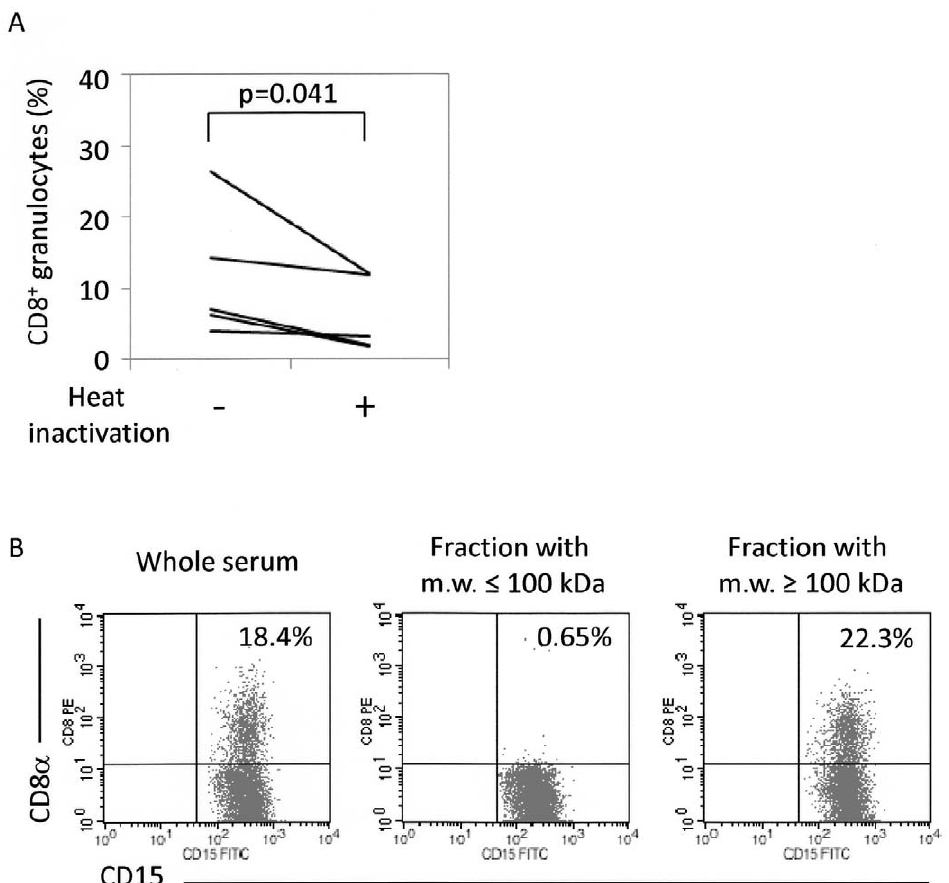
Figure 5. Characterization of serum factors that contribute to Fc c R-mediated trogocytosis. ( A ) Heat instability of serum factors that contribute to Fc c R-mediated trogocytosis (n=5). PMNs and PBMCs were mixed in sera, which had been heated at 56 u C for 30 min, or sera without heat inactivation. These cells were then made to react with the PE-labeled anti-CD8 a Ab (HIT8a). After removal of unbound Abs, the cells were re- suspended in PBS followed by reaction with the FITC-labeled anti-CD15 Ab (H198), and then served for FCM. Student t -test for paired samples was applied for statistical analysis. ( B ) Molecular weight range of serum factors that contribute to Fc c R-mediated trogocytosis. PMNs and PBMCs were mixed in sera, which had been fractionated into those with molecular weight of more than 100 kDa or less than 100 kDa. These cells were then made to react with the PE-labeled anti-CD8 a Ab (HIT8a). After removal of unbound Abs, the cells were re-suspended in PBS followed by reaction with the FITC-labeled anti-CD15 Ab (H198), and then served for FCM. This experiment was repeated 3 times. PE-labeled mouse IgG1 and FITC-labeled mouse IgM were used as isotype-matched controls for HIT8a and H198, respectively.